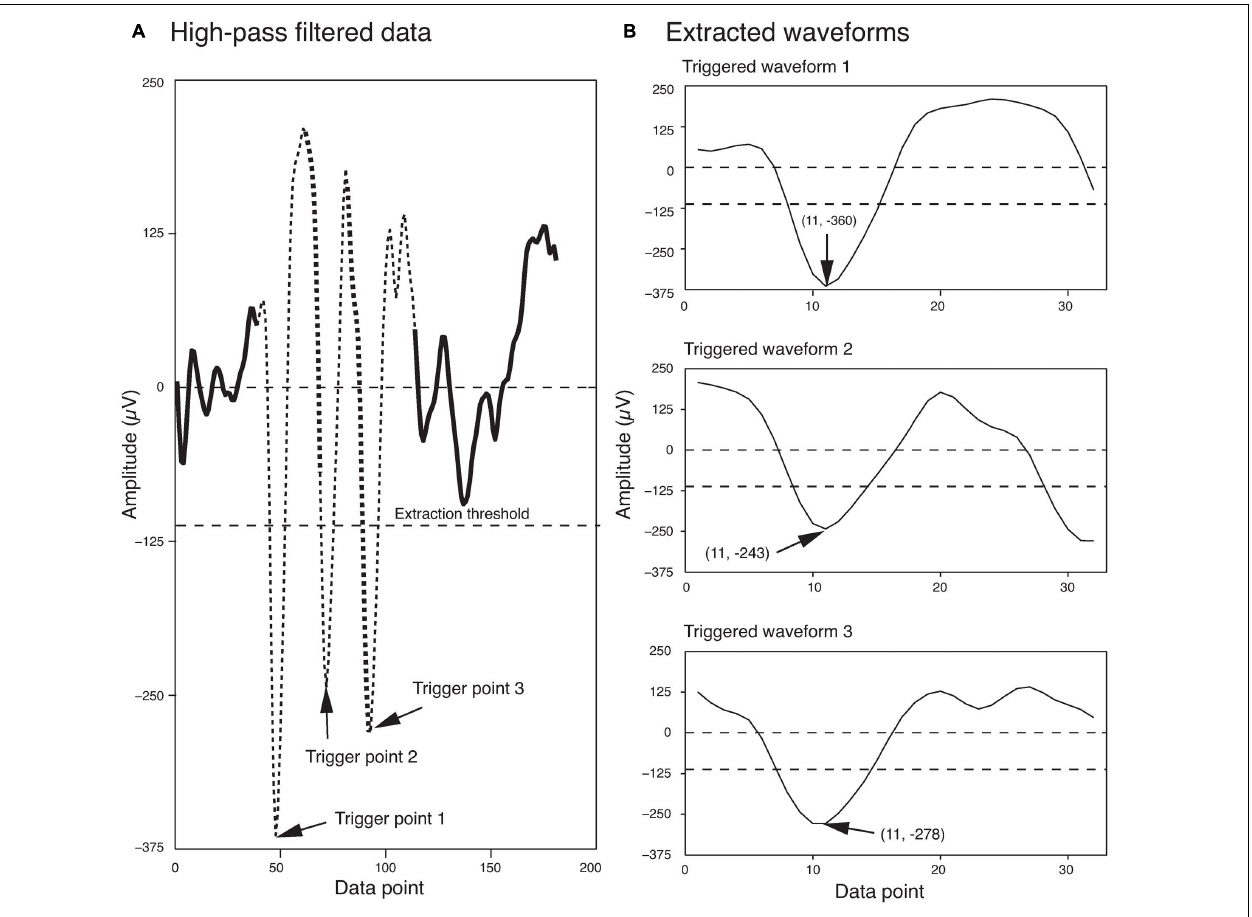
FIGURE 1 | Waveform Extraction. (A) A short segment of the high-pass filtered data is shown here. Three local minima that exceeded the extraction threshold (dashed line) are highlighted by arrows. The extracted waveforms are indicated by thin broken lines. Regions of overlap between the extracted waveforms are indicated by the thick broken lines. (B) The three extracted waveforms corresponding to the three trigger points shown in (A) . The trigger points appear as data point 11 in each of the extracted waveforms. The first and second numbers in the parentheses indicate the data point number and the voltage, respectively.